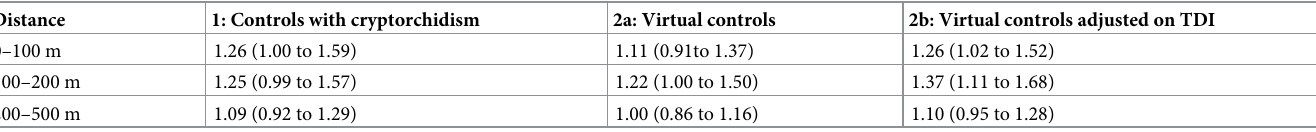
Table 3. Odds ratios, with 95% confidence intervals, of the risk of hypospadias by classes of distance to the closest vineyard. (large distances). Distance